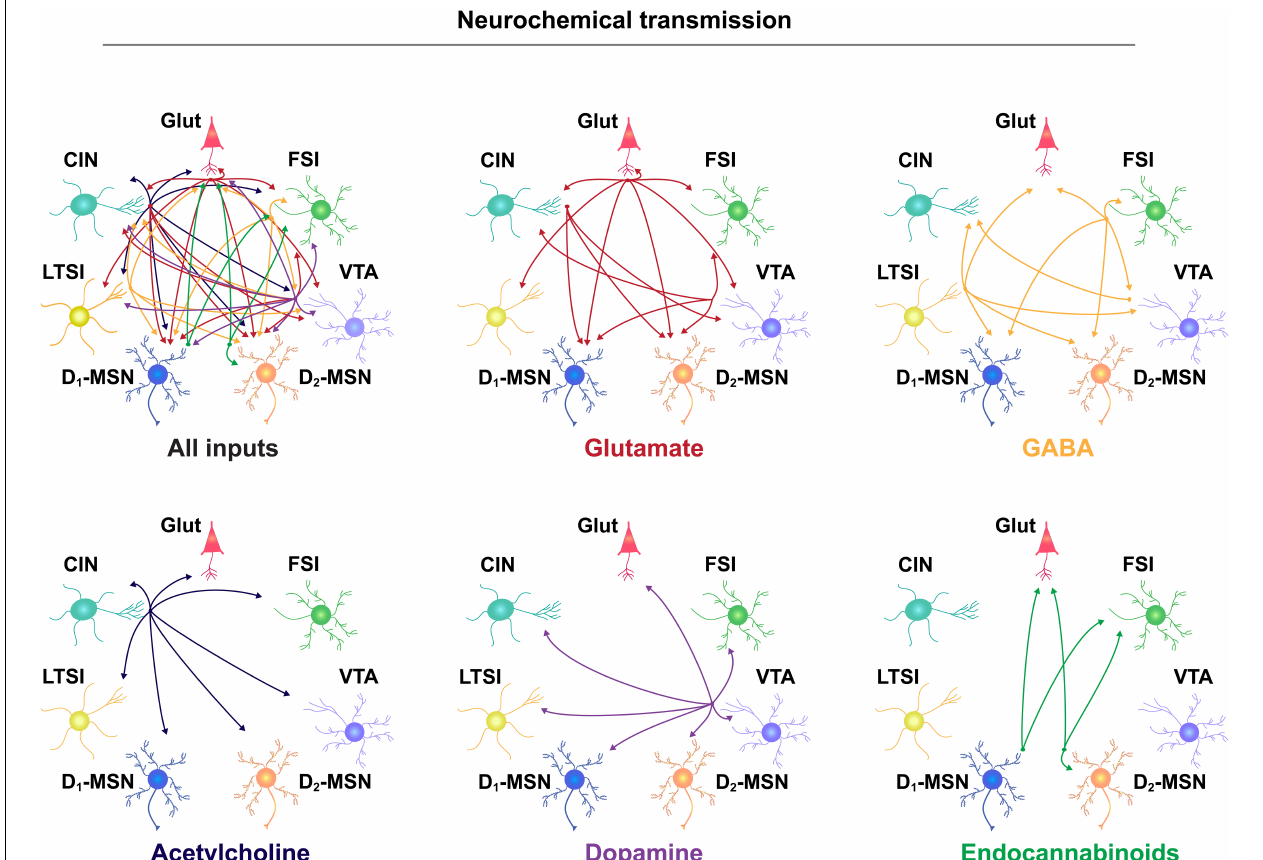
FIGURE 1 | Neurochemical communication in the NAc. Neurotransmitter release from separate cellular populations in the NAc, including glutamatergic (Glut) neurons from throughout the brain, fast-spiking interneurons (FSIs), the ventral tegmental area (VTA), D2- and D1-medium spiny neurons (MSNs), low-threshold spiking interneurons (LTSIs), and cholinergic interneurons (CINs). Input-output relationship is depicted by the direction of the arrow and separated according to neurotransmitter molecule, listed below each